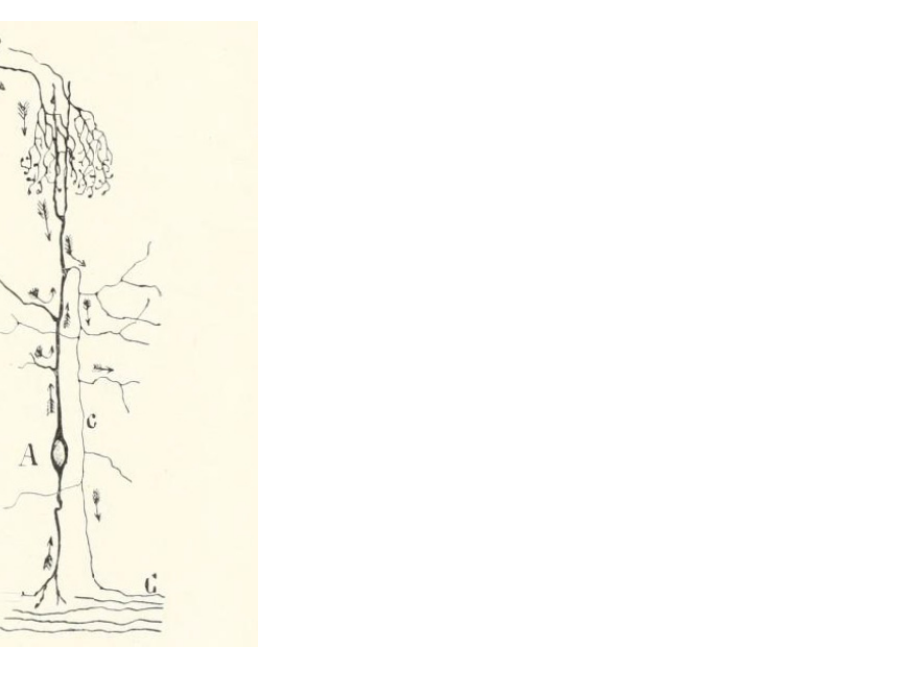
Figure 3. A graphic description of a synapse involved in vision (optic lobe), according to Cajal (1909), using the Golgi staining method. The arrows indicate the direction of the nervous impulse. ( A ) neural body, ( B ) afferent fibres. ( C ) axonal fibre [11].